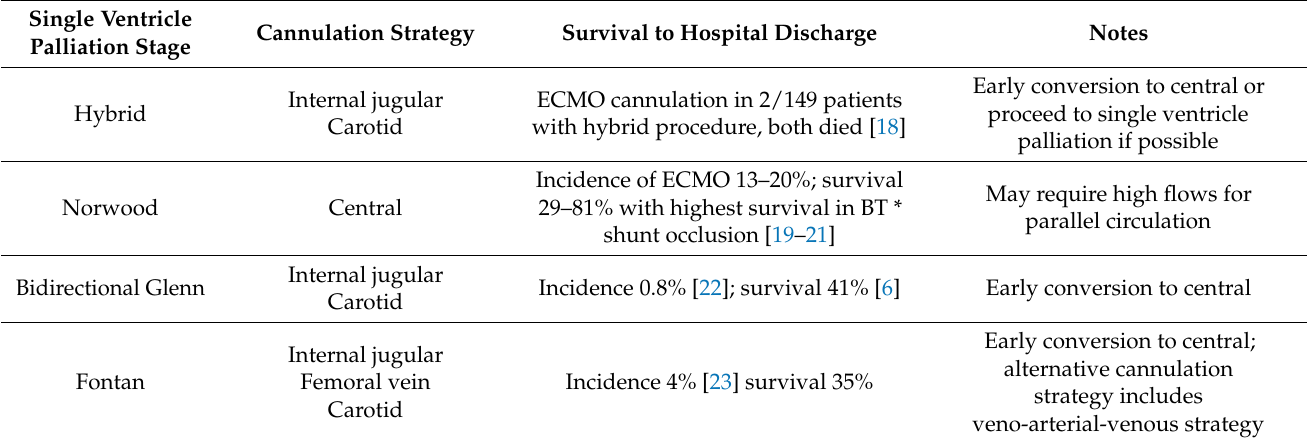
Table 2. Summary of VA ECMO Strategies and Survival in Stages of Single Ventricle